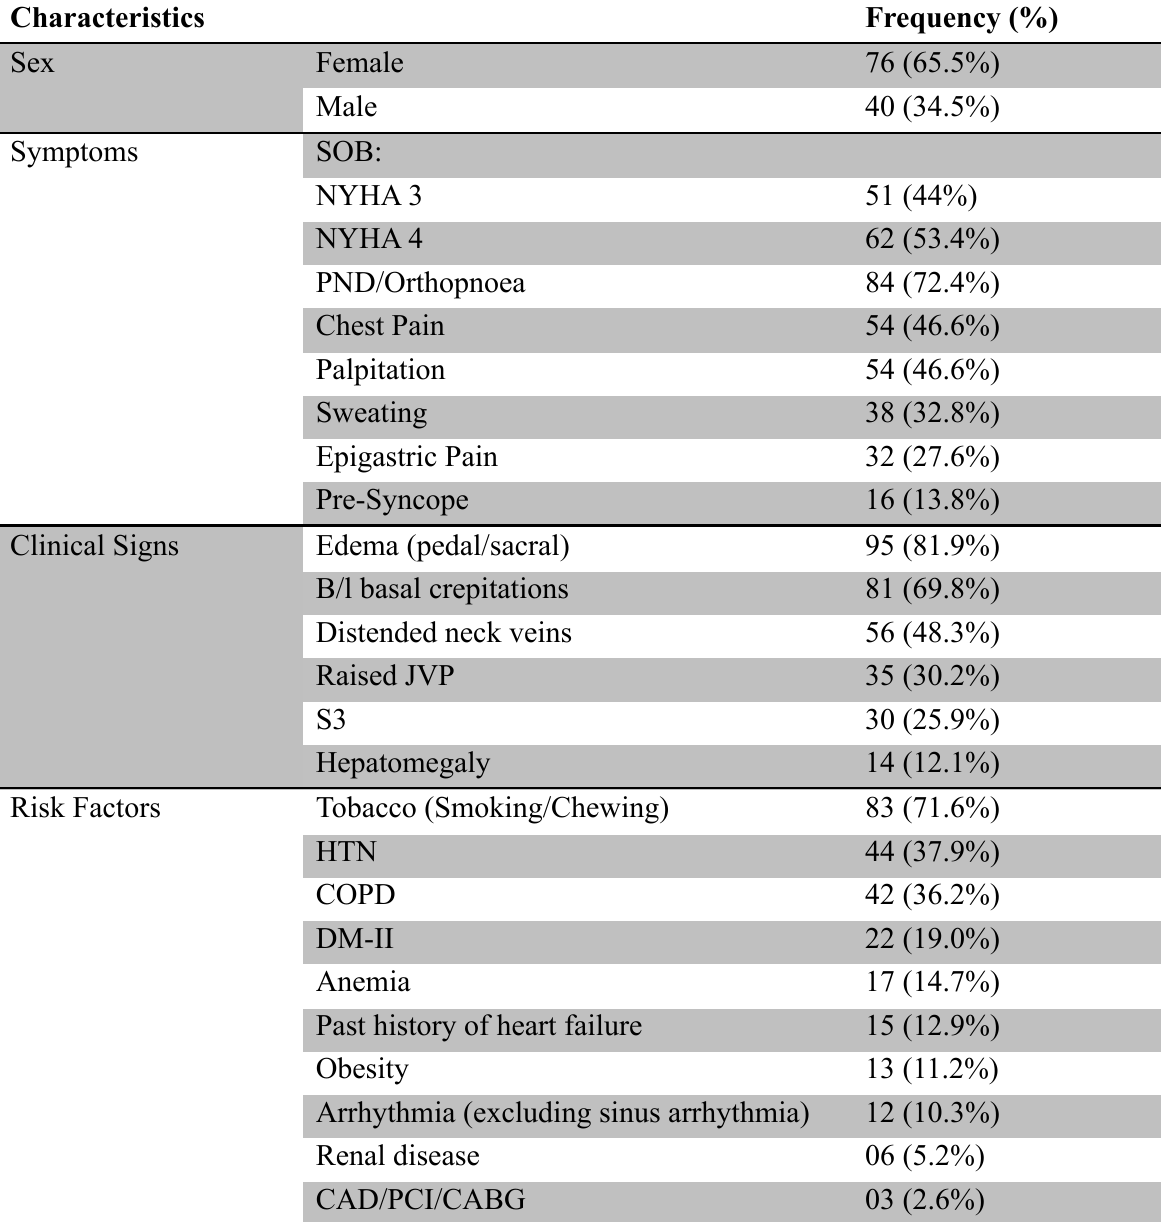
Table 1: Baseline Characteristics, Clinical Presentations and Risk Factors (n=116)